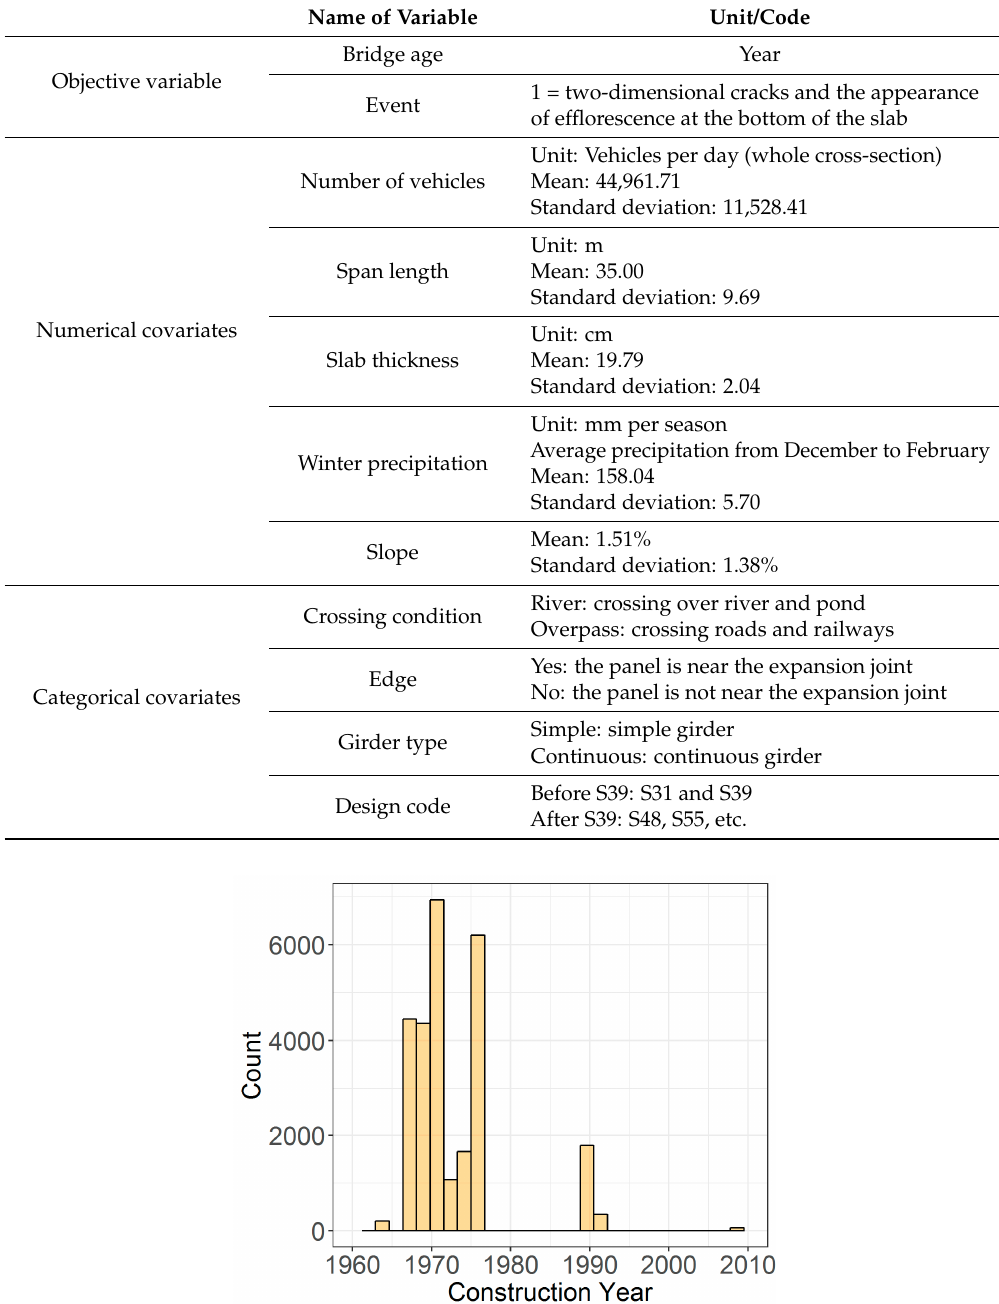
Table 5. Variables used in analysis in Tokyo region. Table 4. Repair types in Tokyo region.